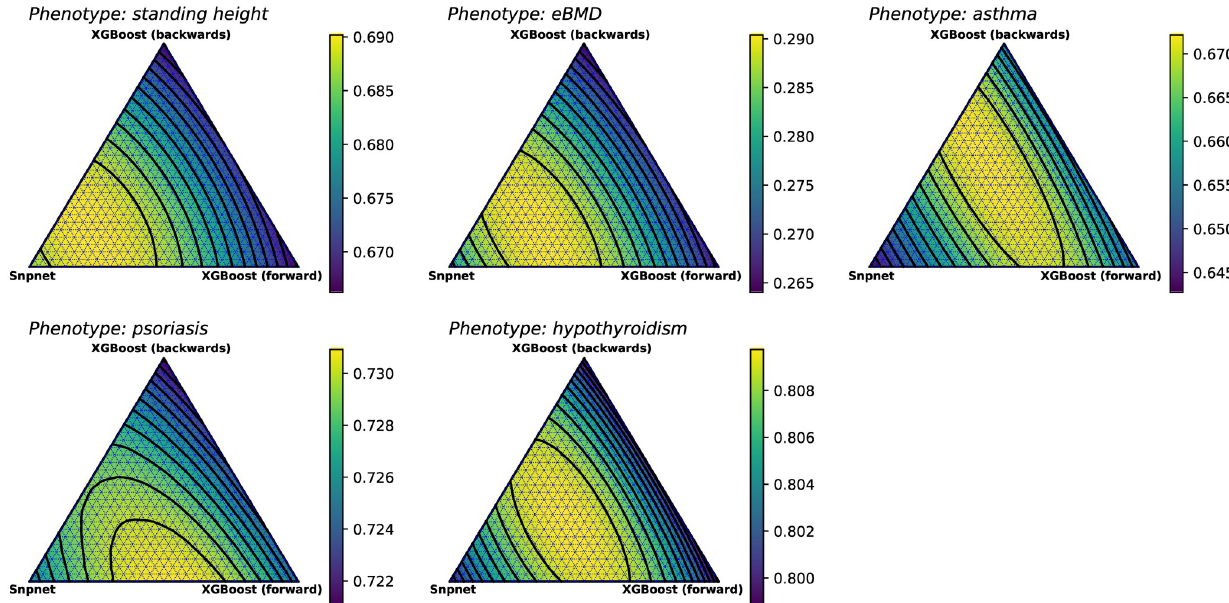
Fig 4. Simplex plots showing the metrics obtained by taking weighted sums from three prediction methods: Snpnet trained on 50k GWAS-selected SNPs, and XGBoost trained on XGBoost selected SNPs (forward and backward passes). The XGBoost models were trained on 10k SNPs for standing height and eBMD, 5k SNPs for psoriasis and hypothyroidism, and 1k SNPs for asthma. Each vertex of a triangle represents the performance of an individual model, with the center of the triangle representing the performance of the unweighted